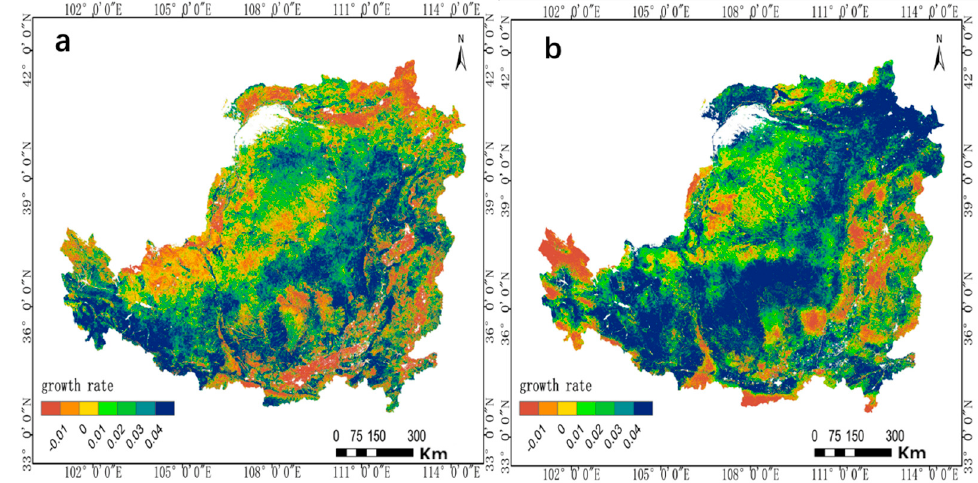
Figure 4. ( a ) Trend of WUE of Loess Plateau 2001 − 2010. ( b ) Trend of WUE of Loess Plateau